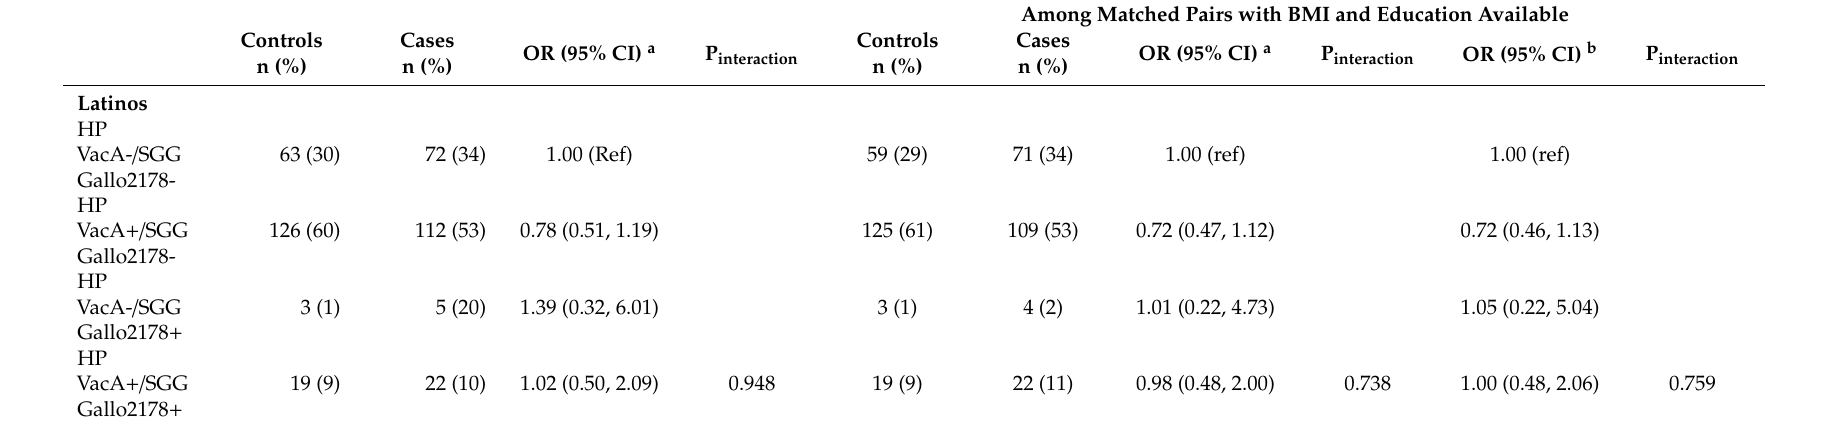
Table 2. Cont. Among Matched Pairs with BMI and Education